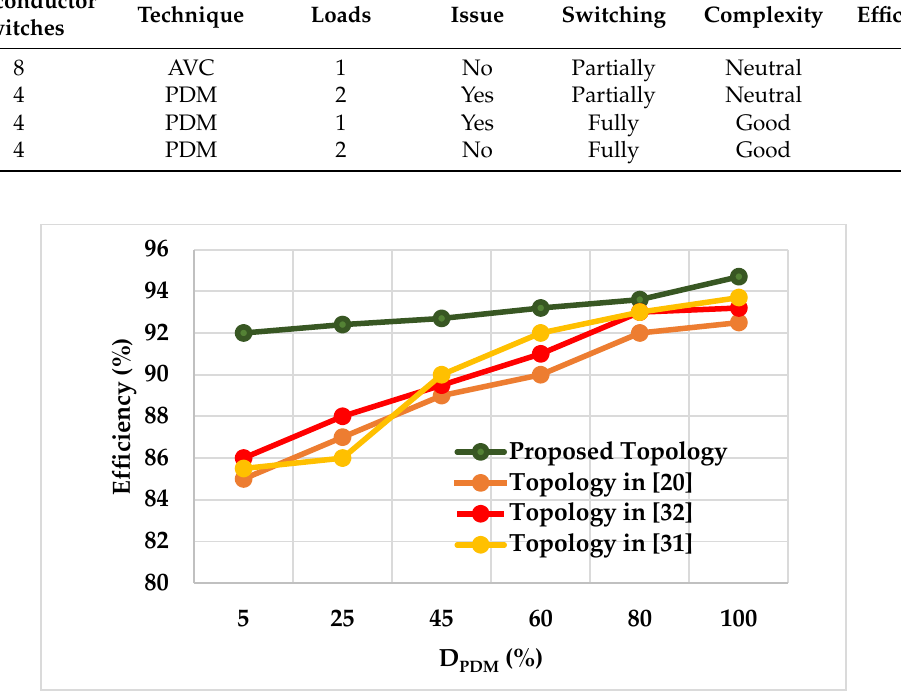
Figure 15. Efficiency variations for distinct load power.